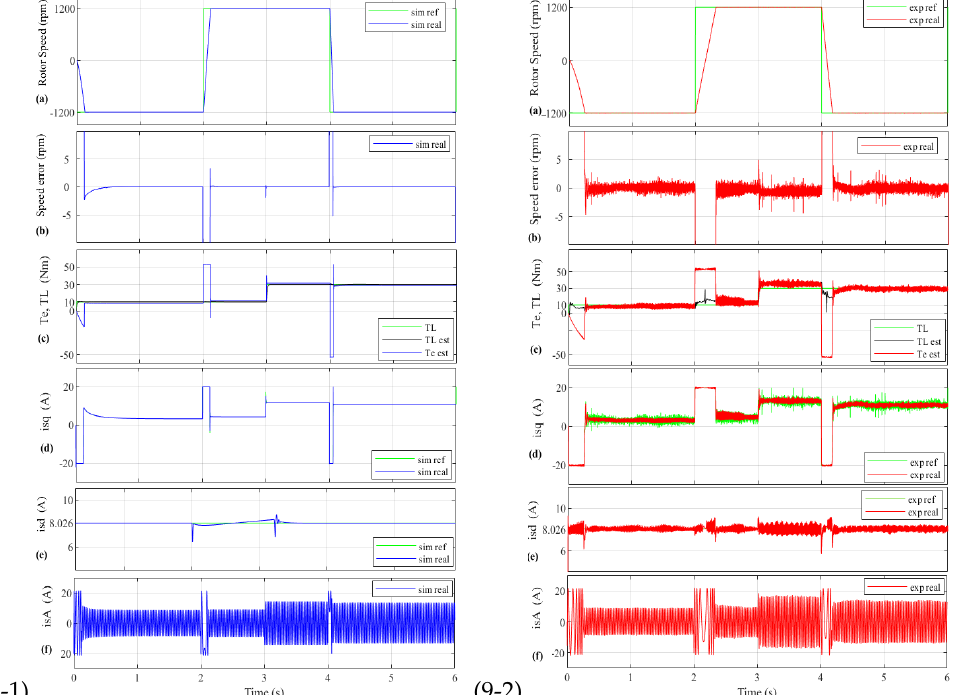
Figure 9. IM performance with 60% of uncertainties in J at 1200 rpm reference speed and two load torque step changes, ( 9-1 ) Simulation and ( 9-2 ) Experimental (D2 design): ( a ) Rotor speed; ( b ) Speed error; ( c ) T e , T L ; ( d ) Torque current; ( e ) Rotor flux current and ( f ) Stator